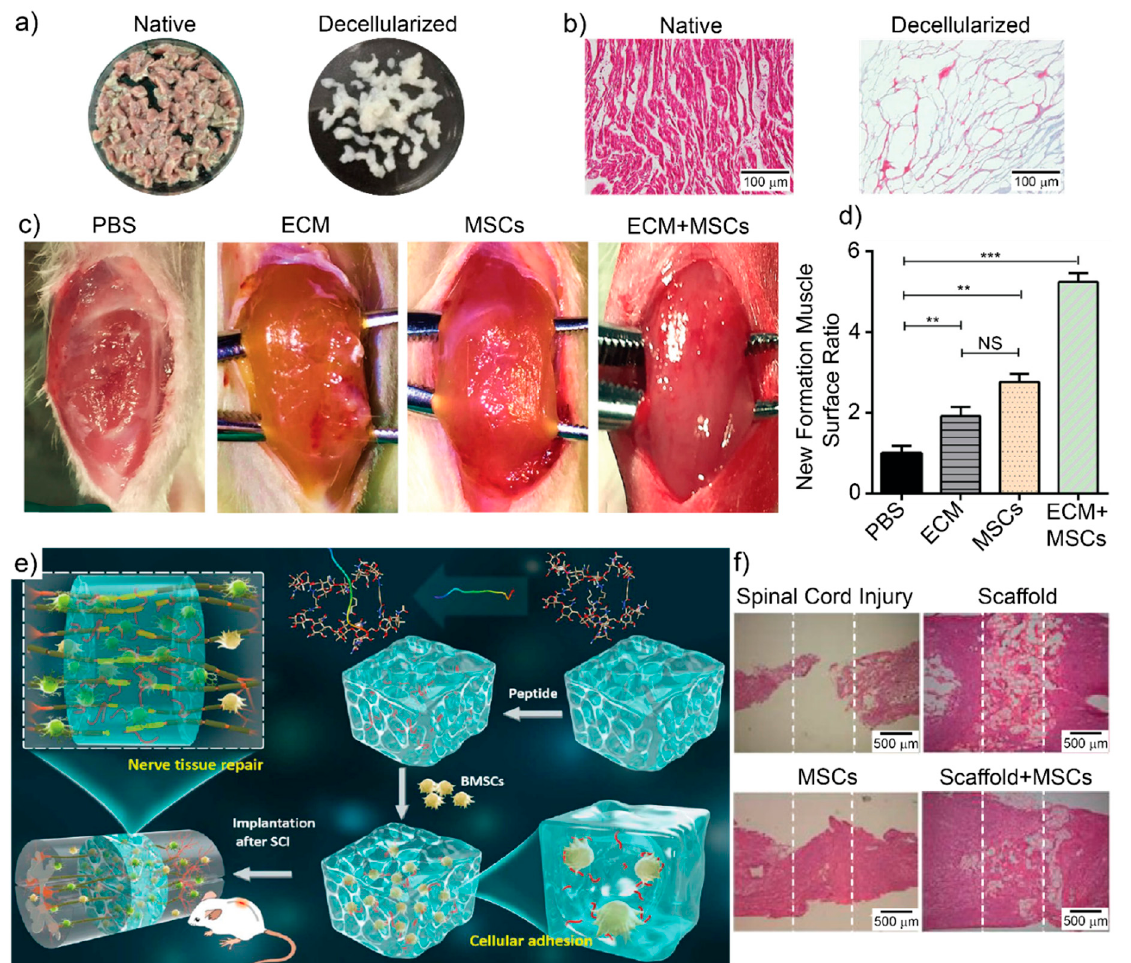
Figure 4. Synergistic approaches combining multifunctional scaffolds with cell-based therapy for TERM. ( a ) Representative optical images of native and decellularized heart tissue. ( b ) Masson’s trichrome staining confirming absence of cells and cell debris in the matrix after decellularization. ( c ) Gross appearance of the volumetric muscle loss injury in four groups and ( d ) surface ratio of new muscle fibers formed in each group. MSCs and ECM scaffold have a synergistic effect promoting muscle tissue regeneration. Data shown as mean ± SD. ** p < 0.01; *** p < 0.001; NS, not significant ( p > 0.05). PBS phosphate buffer saline. ( e ) Scheme of the adhesive peptide modified hyaluronic acid scaffold loaded with bone marrow MSCs for spinal cord injury repair. ( f ) H&E staining of nontreated tissues (spinal cord injury) and tissues embedded with implants at 4 weeks postsurgery. Encapsulation of MSCs significantly improved nerve tissue reconnection effect of the scaffold. ( a – d ) adapted from [159], BioMed Central, 2018. ( e – f ) adapted with permission from [161], American Chemical Society,